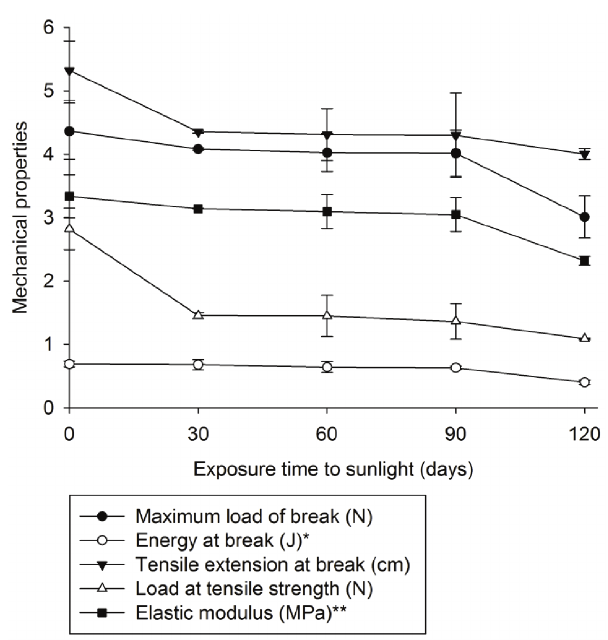
Figure 1. Mechanical properties of the oxo-biodegradable plastic before and after 30, 60, 90 or 120 days of sunlight exposure. *Value was multiplied by 10, ** Value was divided by